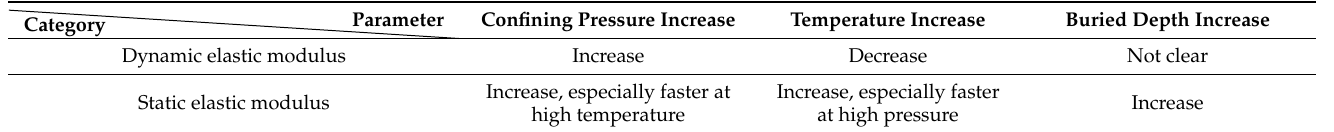
Table 2. Variation in dynamic and static elastic modulus under different confining pressures and temperatures.